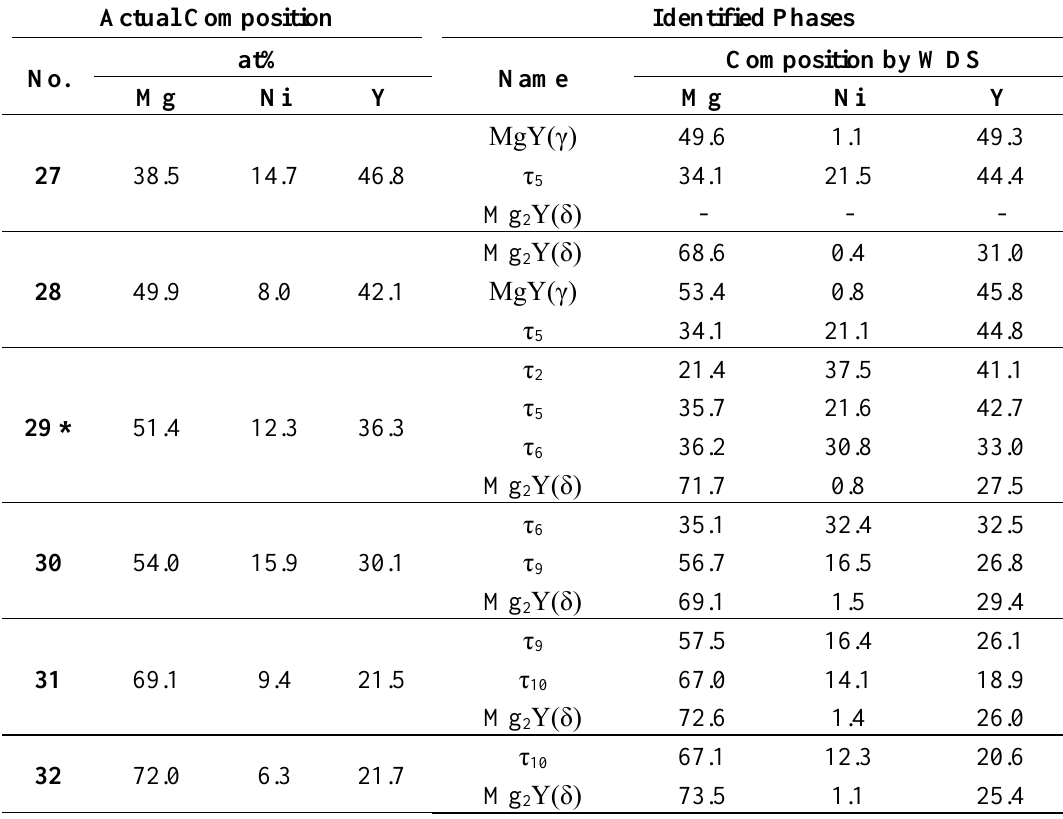
Table 7. WDS data of the samples 27–32 annealed at 673